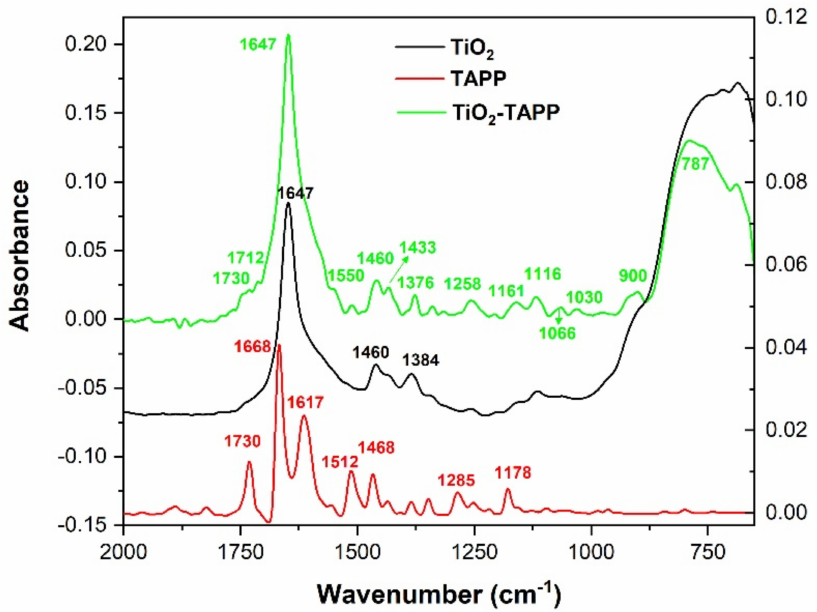
Figure 4. FTIR–ATR spectra of TiO 2 NPs, TAPP, and TiO 2 NPs loaded with TAPP. Left axis cor- responds to TiO 2 -TAPP spectrum, while right axis corresponds to TiO 2 and TAPP spectra. TiO 2 spectrum is vertically